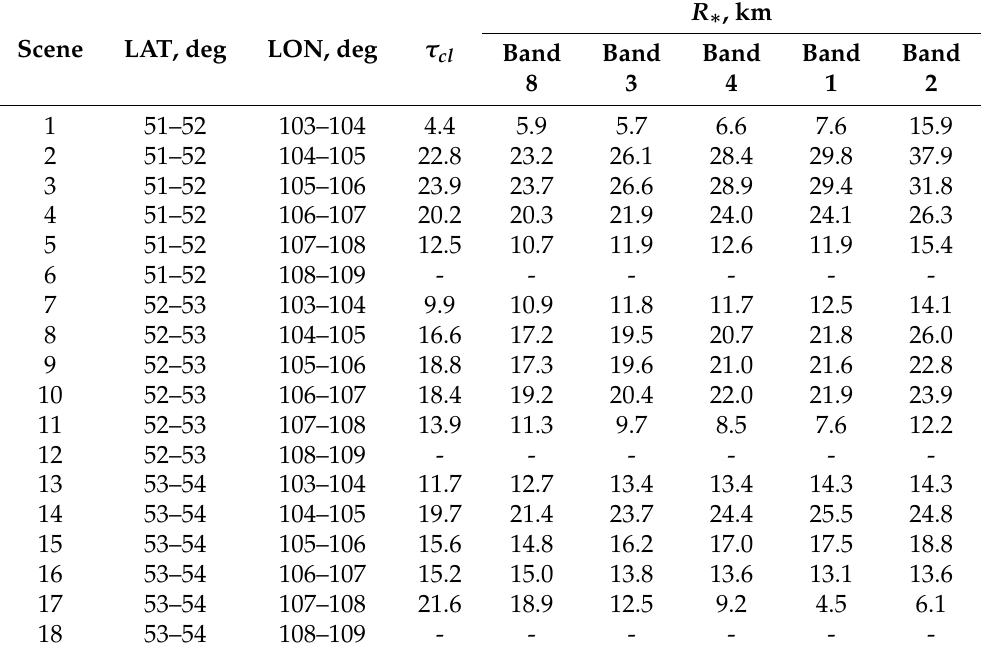
Table 3. Values of R ∗ for five MODIS bands and 18 scenes on 2 July 2021. The data for scenes 6, 12, and 18 are omitted because of the lack of initial information on τ .